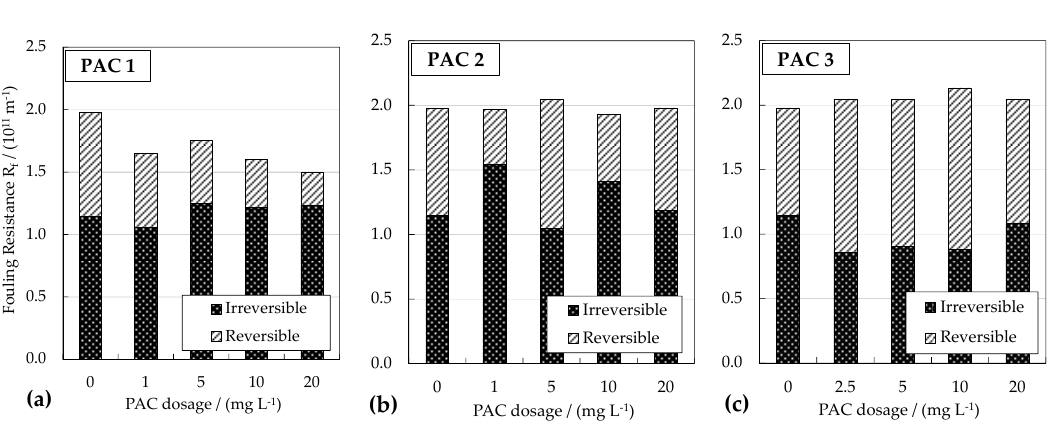
Figure 5. UF with pre-deposition of raw PACs: Average hydraulic reversible and irreversible fouling resistance after filtration of raw water with pre-deposition of ( a ) PAC 1, ( b ) PAC 2 and ( c ) PAC 3 in varying concentrations. (Membrane: 150 kDa; PES; 2.87 × 10 − 3 m 2 ; V F = 500 mL; n = 2 − 3).